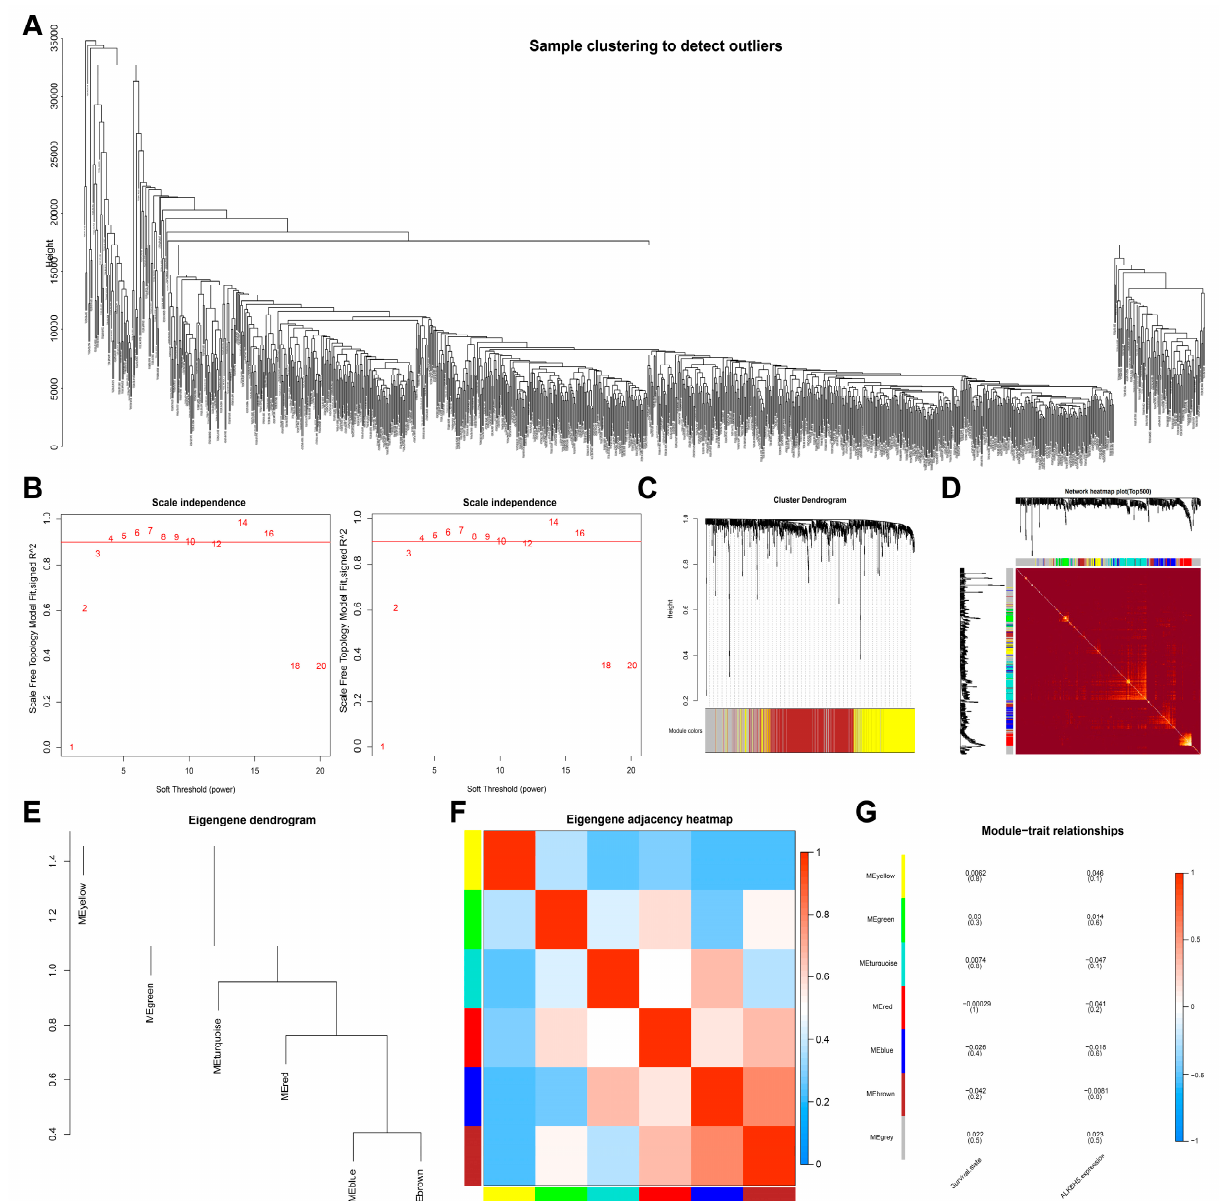
Figure 1. Screening of module genes associated with ALKBH5 expression by WGCNA. ( A ): A cluster diagram of TCGA-BRCA samples ( n = 1,089). One “branch” represents one sample; ( B ): The scale-free fitting index of network topology using soft threshold power analysis. Soft threshold (power) in the left represents the weight, and the ordinate represents the correlation between connectivity k and p (k). It is generally required that power with the correlation reaching 0.8 is used as a β value. Soft threshold (power) in the right indicates weight, and the ordinate represents the average connectivity degree; ( C ): A gene co-expression network constructed by WGCNA. Each color represents a module in the network; ( D ): Correlation analysis of the co-expressed gene interaction. Different colors of the abscissa and ordinate represent different modules, and the brightness of yellow in the middle indicates the connection degree of different modules. No significant difference in the interaction between modules indicates that the scale has a high degree of independence between the modules; ( E ): Cluster analysis of different modules; ( F ): Correlation analysis of different modules. Color from blue to red indicates the overall expression of the first principal component gene module eigengene from low to high; ( G ): Correlation analysis of the different modules with the ALKBH5 expression. Different colors indicate the different